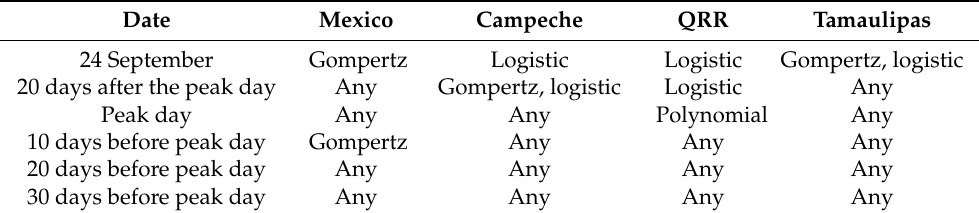
Table 3. Model comparison summary according to Vuong’s